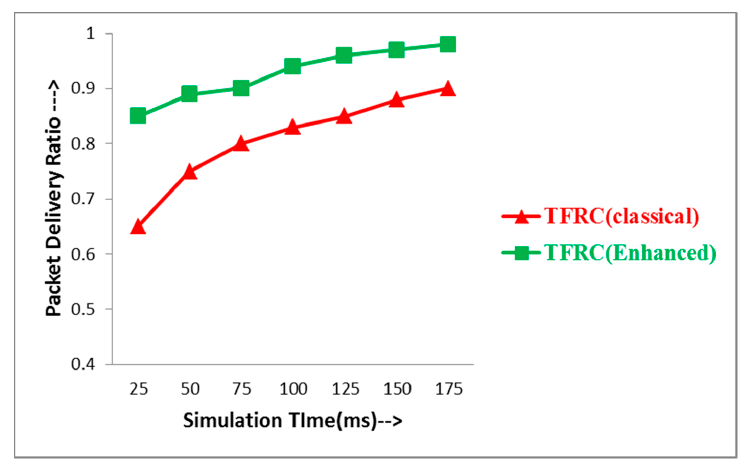
Figure 6. Comparison of packet delivery ratio between classical and enhanced TFRC.